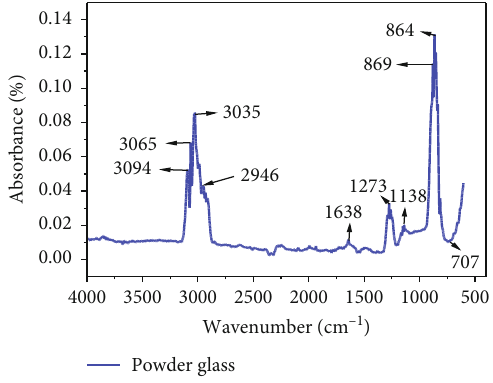
Figure 6: Waste glass powder FTIR spectrum.